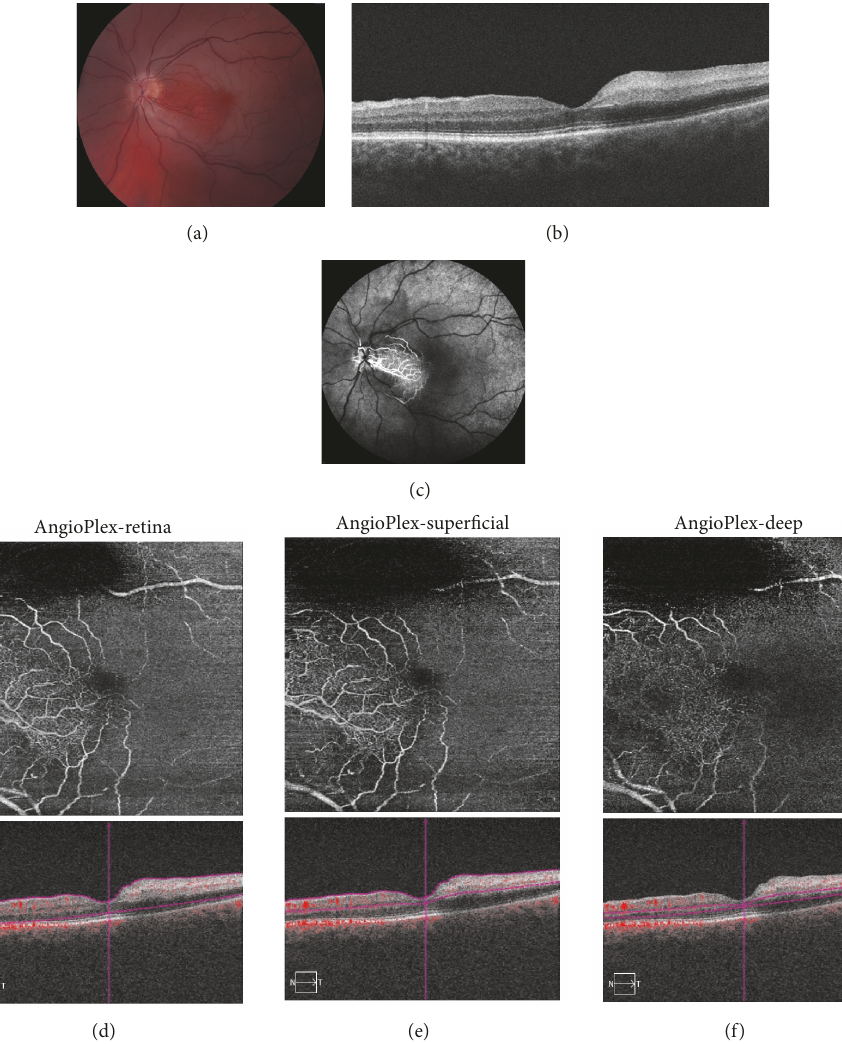
Figure 2: Acute central retinal artery occlusion with cilioretinal sparing, left eye. (a) Fundus photography reveals macular whitening with cilioretinal artery sparing. (b) Spectral domain optical coherence tomography (SD-OCT) reveals macular thickening and hyperreflectivity of the inner retinal layers temporal to the center of the macula, consistent with cilioretinal artery sparing. (c) Fluorescein angiography (FA)